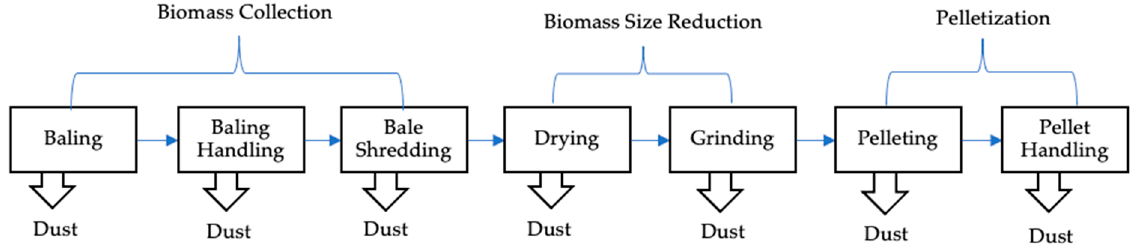
Figure 1. The sequence of operations for collecting and pelletizing crop residue. The operations from baling to bale shredding are specific to herbaceous biomass.